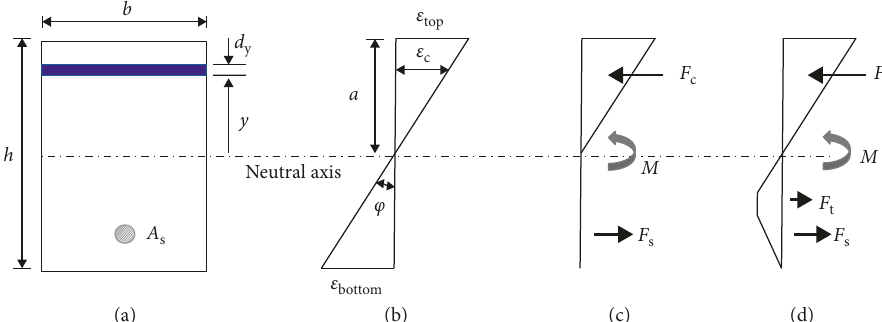
Figure 14: Strain and stress distributions in the section: (a) cross section; (b) strain distribution; (c) stress distribution of HSC; (d) stress distribution of HSFRC.